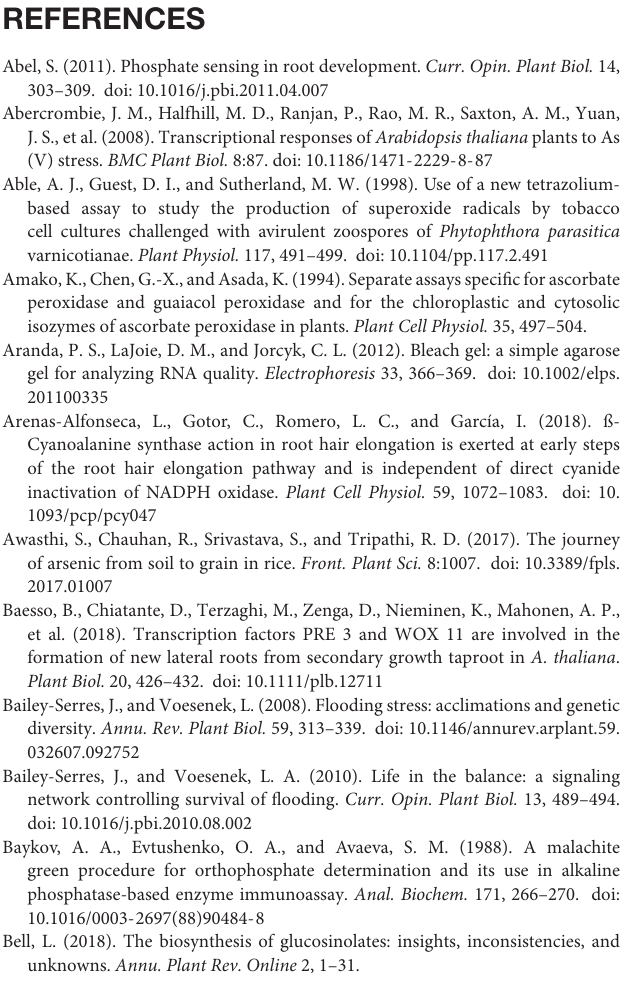
Supplementary Figure 2 | Quantitative RT-PCR analysis results for transcript amounts of hypoxia markers. Supplementary Figure 3 | XTT reductase activity in soluble protein extract.